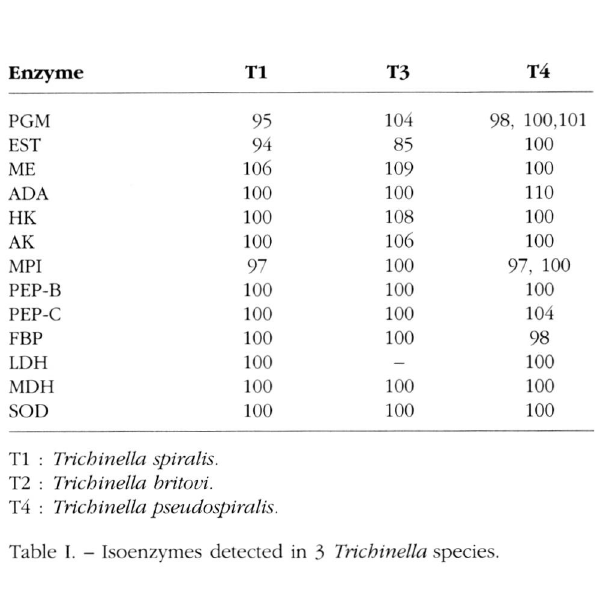
Table I. - Isoenzymes detected in 3 Trichinella